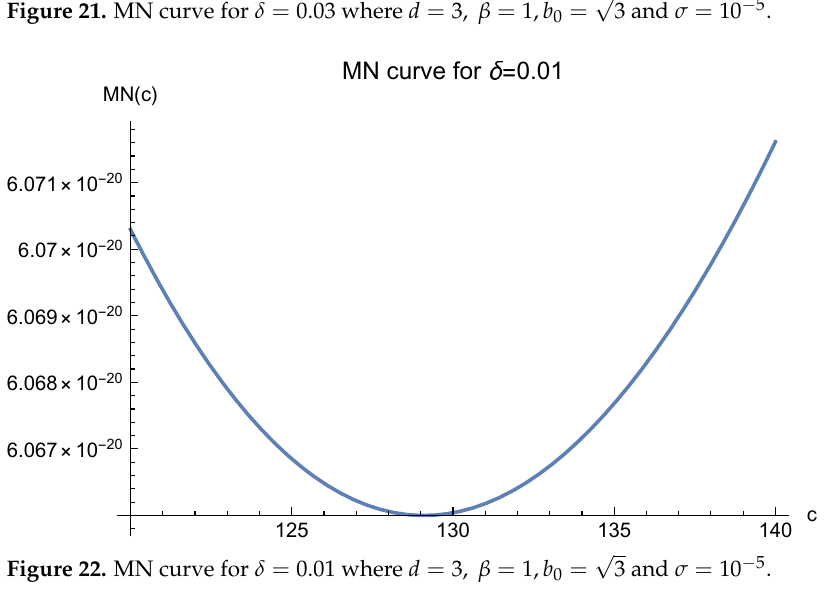
Figure 23. MN curve for δ = 0.05 where d = 3, β = 1, b 0 =